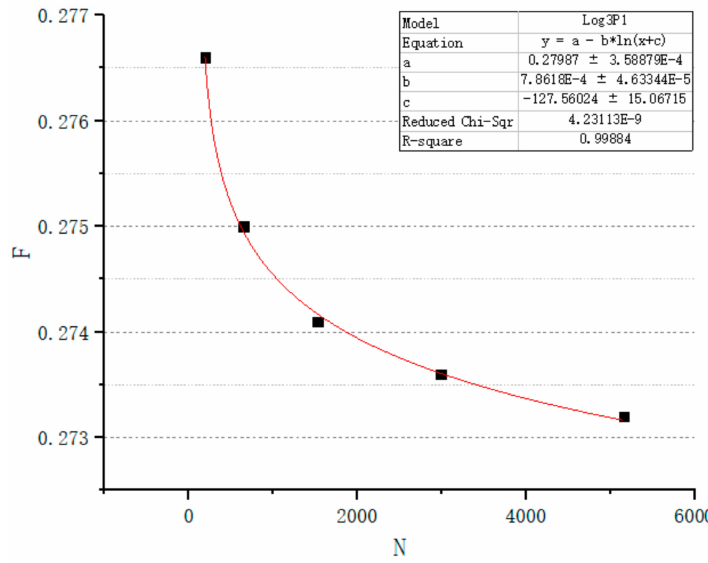
Figure 19. Relation between N and actual